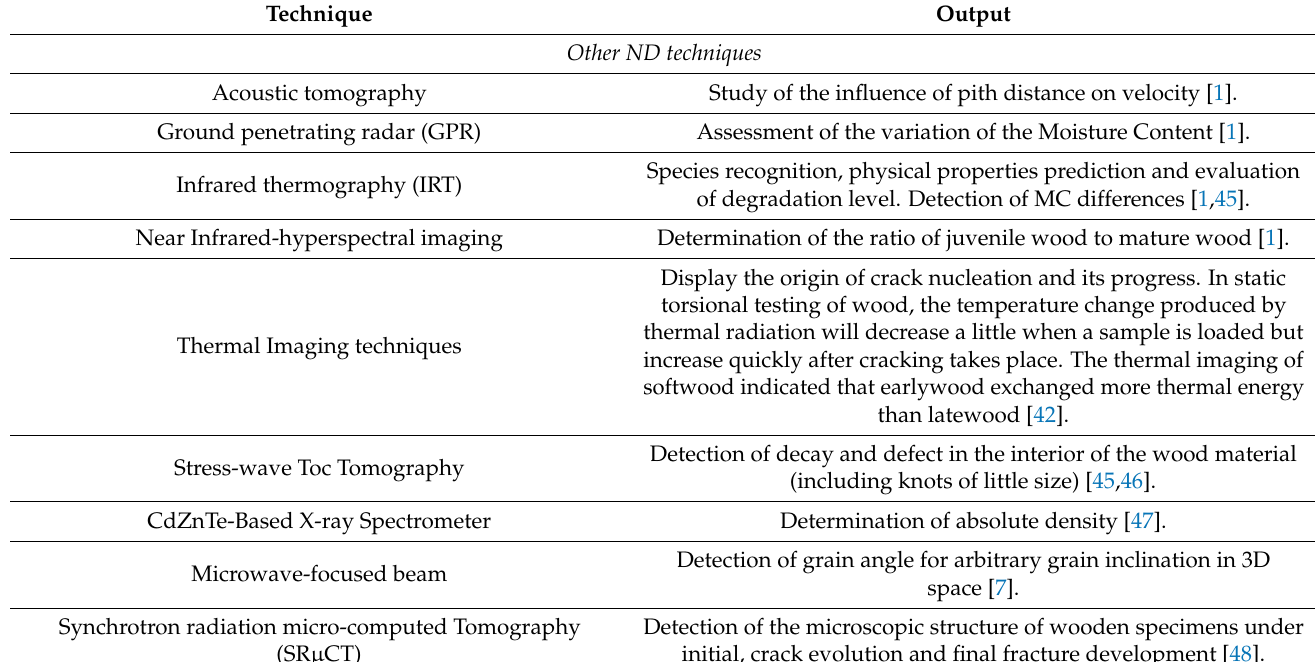
Table A2. Non-destructive techniques mainly used for timber grading and assessment of existing timber structures and their corresponding